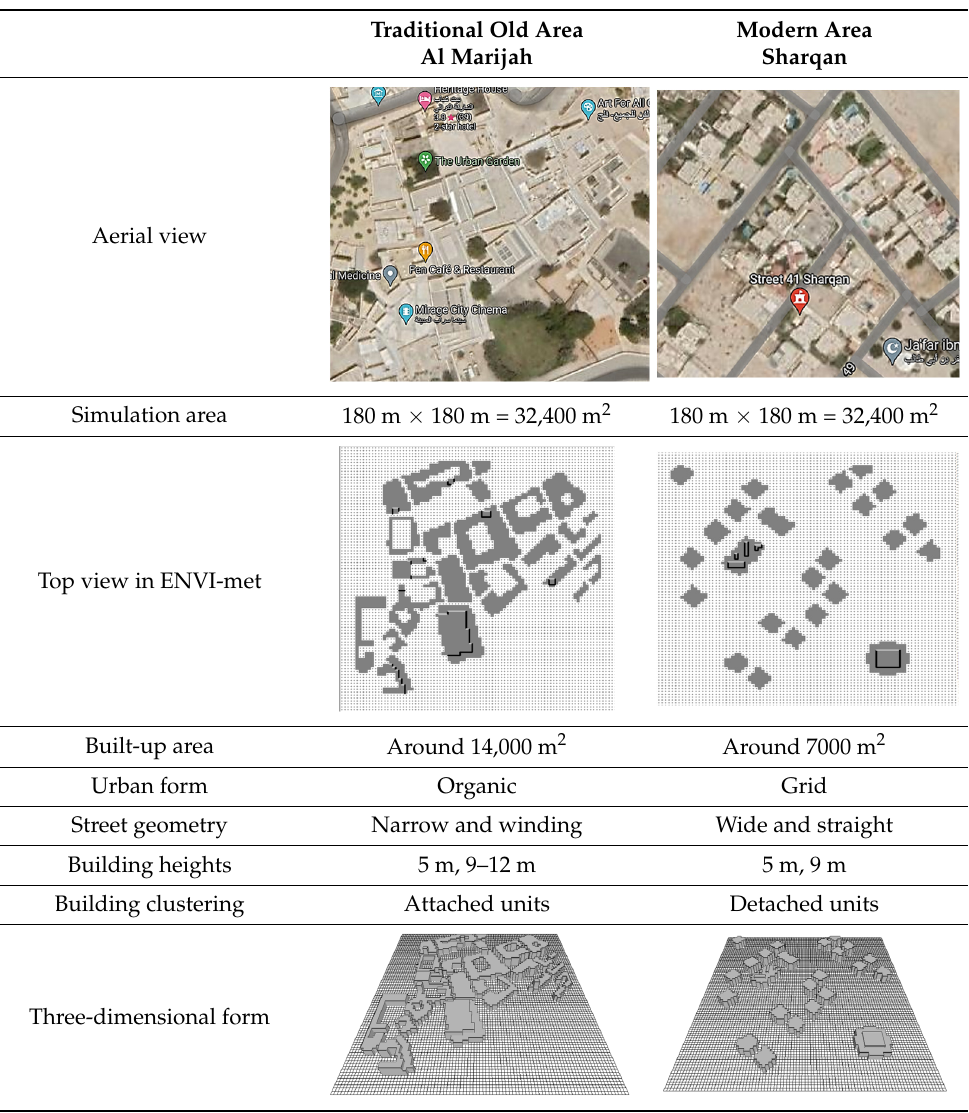
Table 2. Case study features.